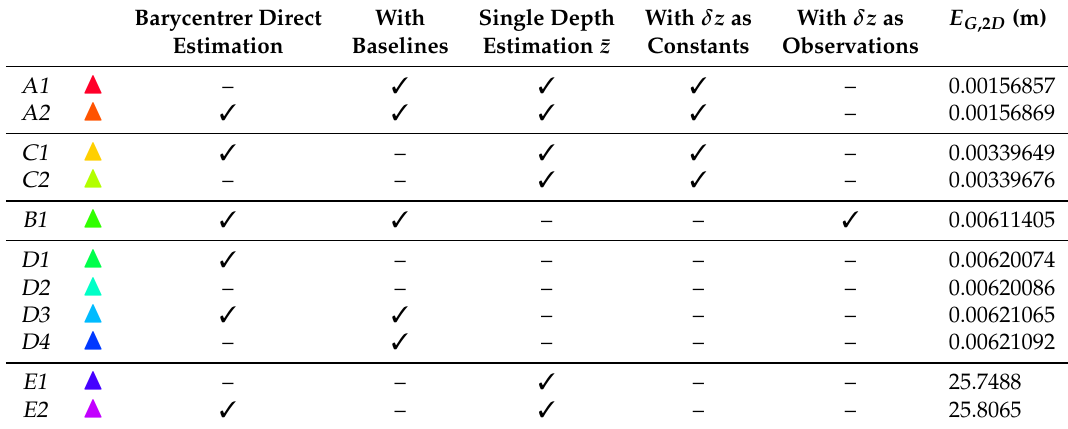
Table 4. Distance to true barycenter for different inversion protocols for a three straight lines